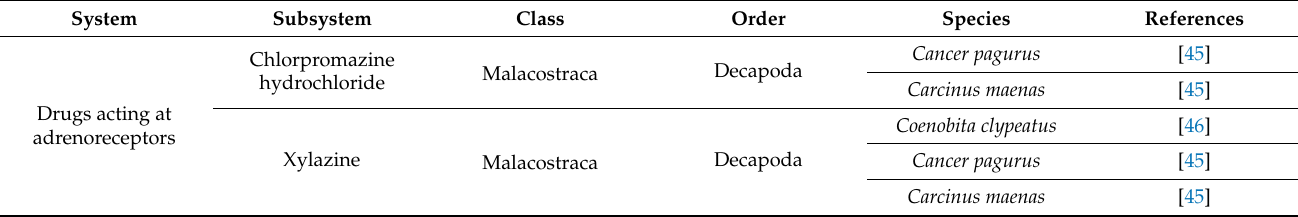
Table 2. List of anesthetic agents and other chemical used in